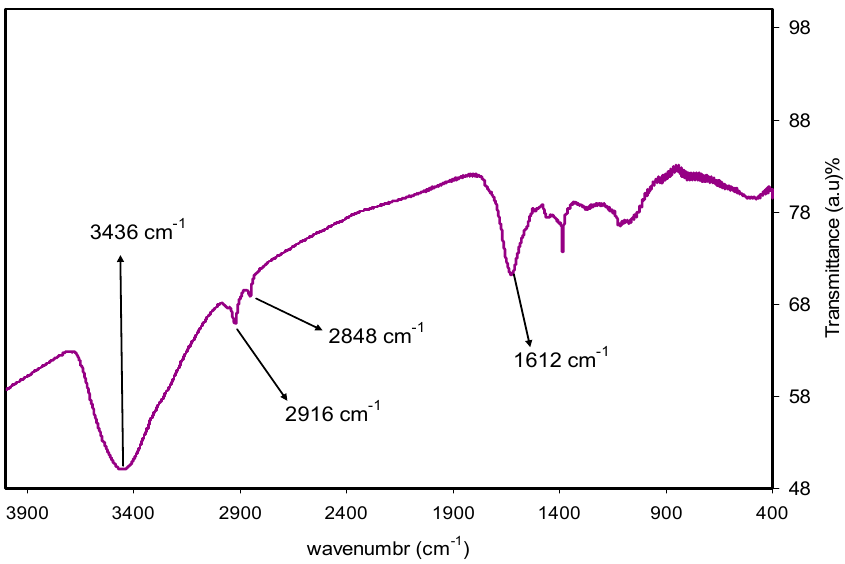
Figure 2. FTIR spectra for silver metal nanoparticles.